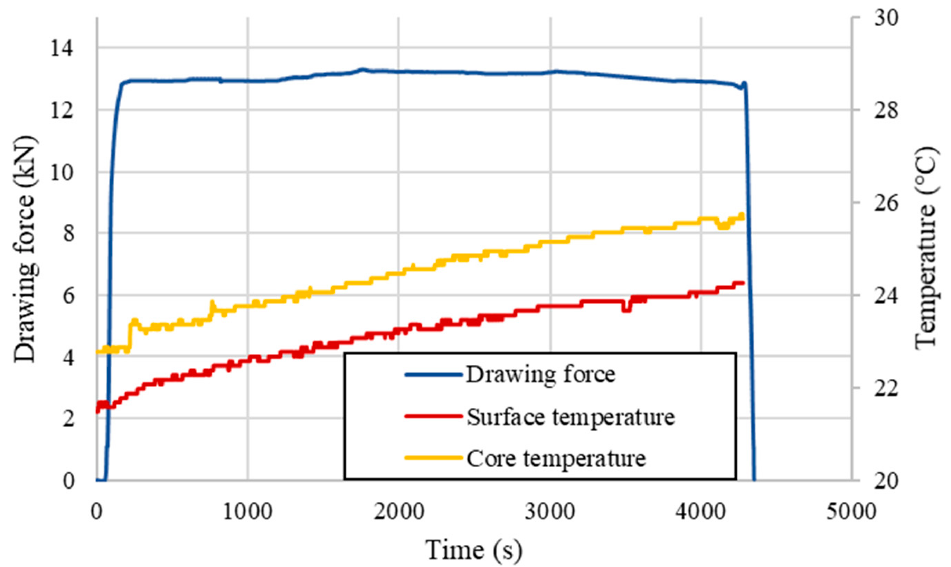
Figure 7. Recorded temperature increase during analyzed wire drawing process (with the use of thermocouples) .